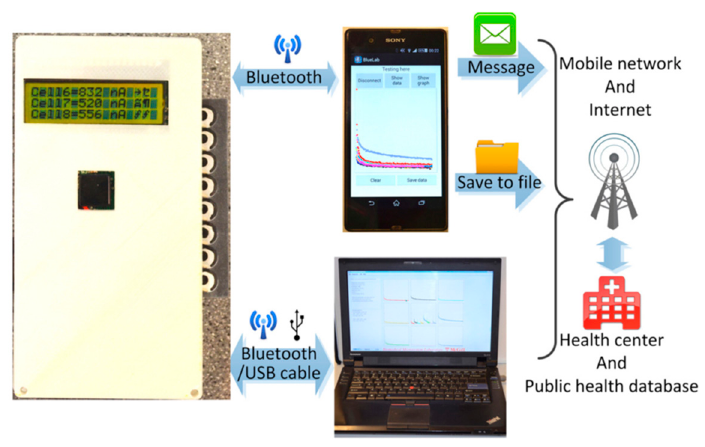
Figure 7. Paper-based microfluidic platform with wireless communication for telemedicine. Reprinted with permission from [127]. Copyright 2016 AIP Publishing.